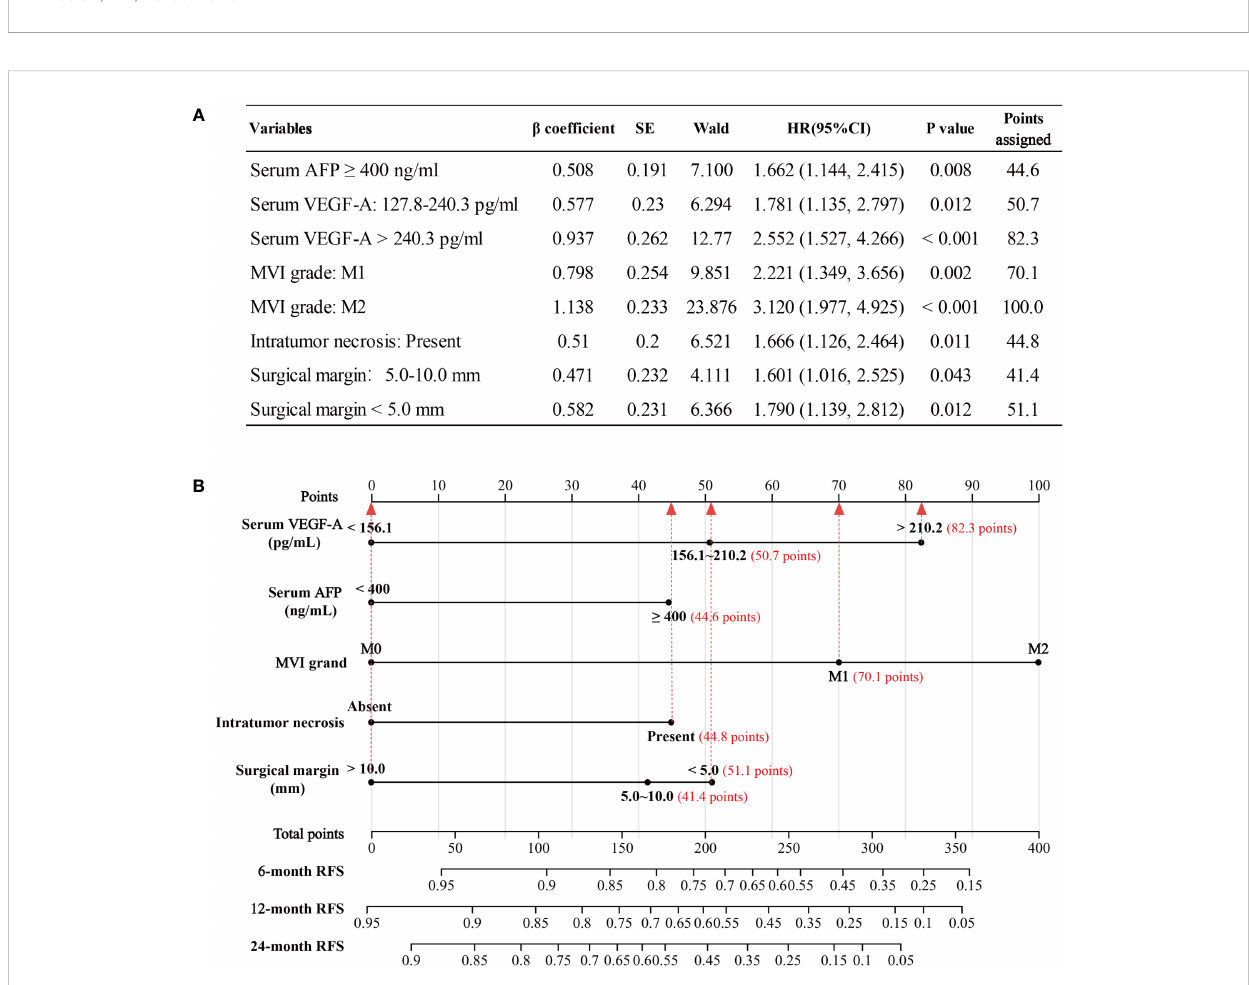
FIGURE 4 The forest plot of multivariate Cox regression analysis. AFP, alpha fetoprotein; VEGF-A, Vascular endothelial growth factor A; MVI, microvascular invasion; HR, hazard ratio.